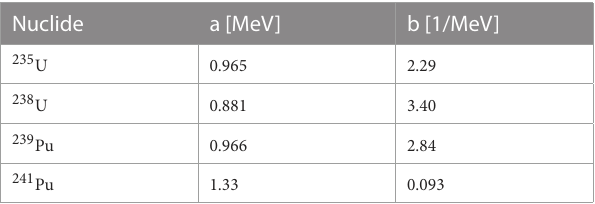
TABLE1 NuclideWattenergyspectraconstants(Davidson et al.,2021)used forpromptfissionneutronspectrumdescriptionforSourceJandK.